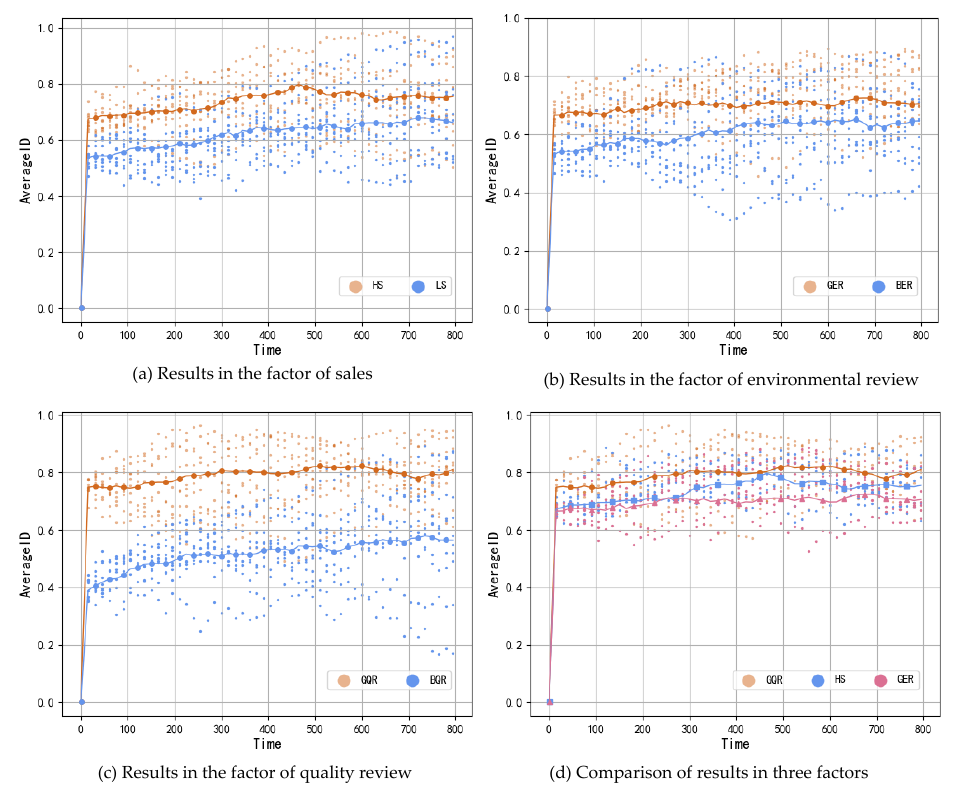
Figure 3. Output diagram of average intention results in a single-factor